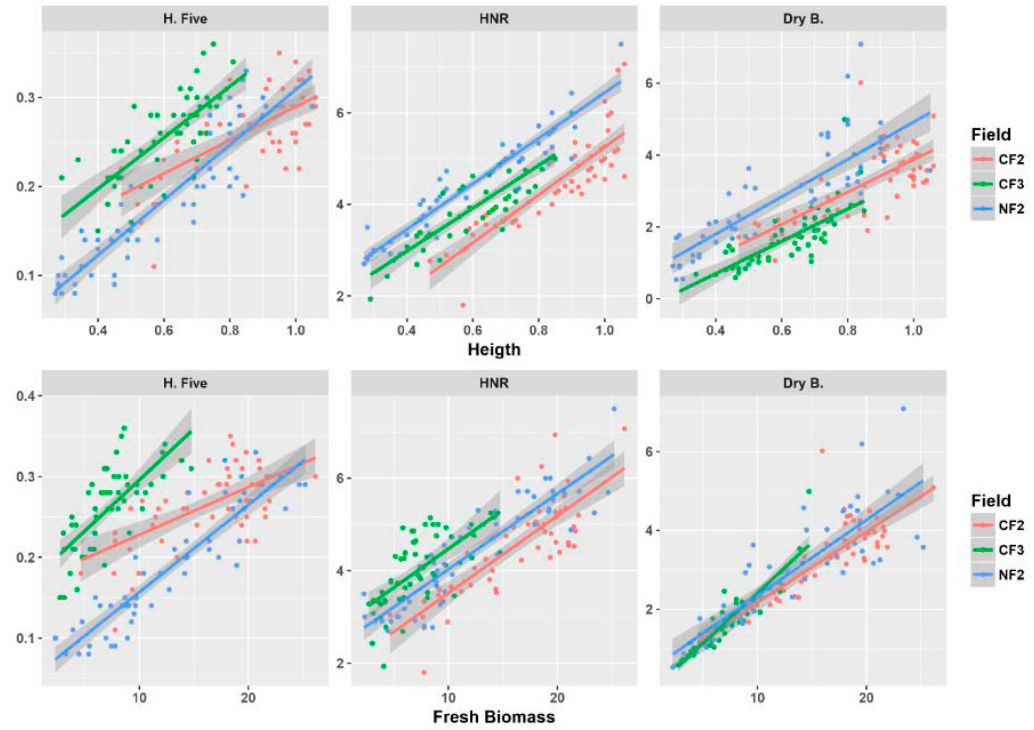
Figure A3. Relation of hand measured crop height and aboveground fresh biomass with height of top five nodes (H. Five), height-to-node ratio (HNR) and dry biomass (Dry B.) for cotton cultivated in two systems: narrow row (NF2) and conventional row spacing (CF2 and CF3).